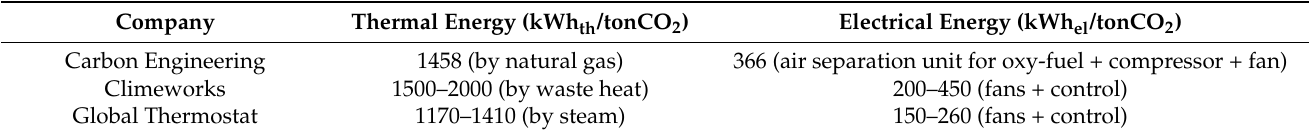
Table 5. Energy consumption for the main DAC companies [129].